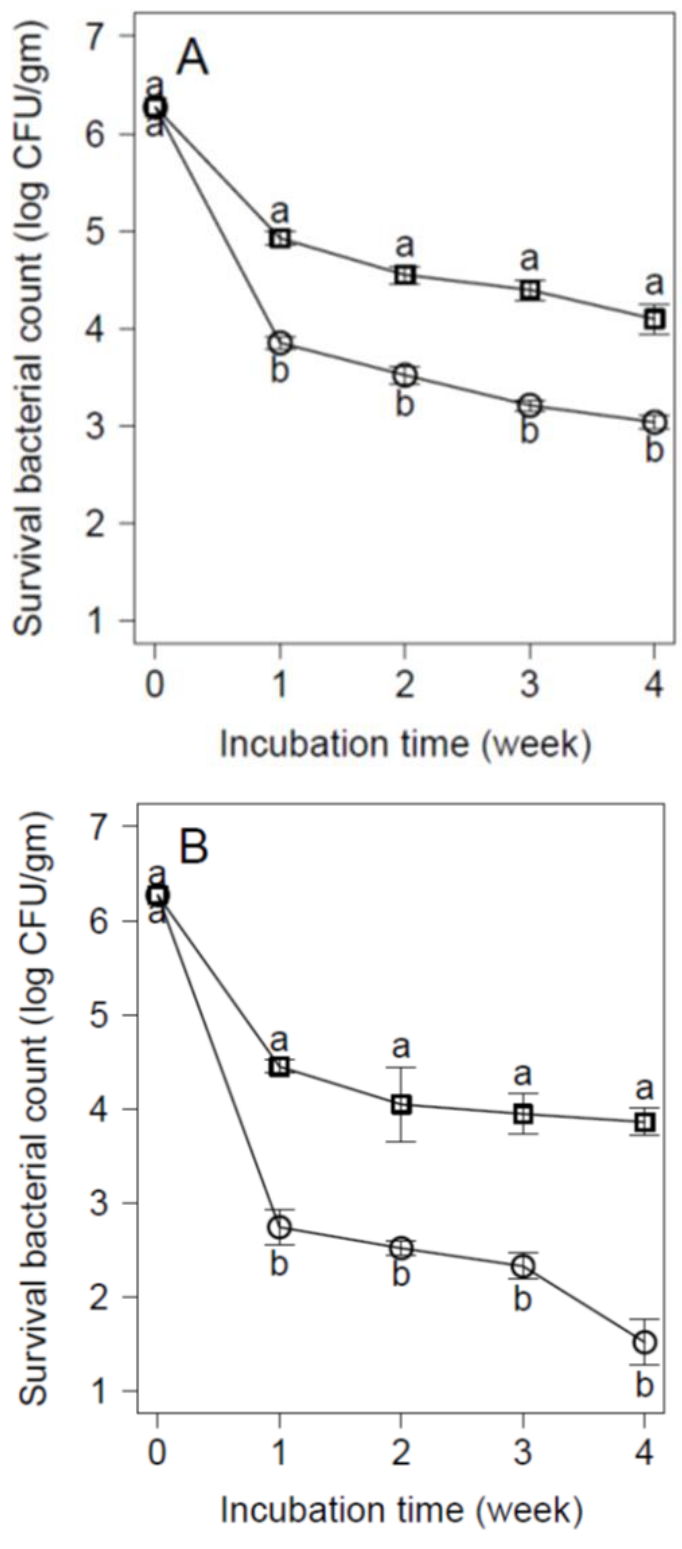
Figure 3. Inhibitory effect of D-tryptophan (0 mM D- Trp, □; 40 mM D - Trp, Ο) on the viable counts of E. coli O 26 inoculated into cheese with ( A ) 1.5% NaCl and ( B ) 3% NaCl at 4 °C. Values are the mean ± standard deviation of three independent trials. Values with different letters are significantly different ( p < 0.05).